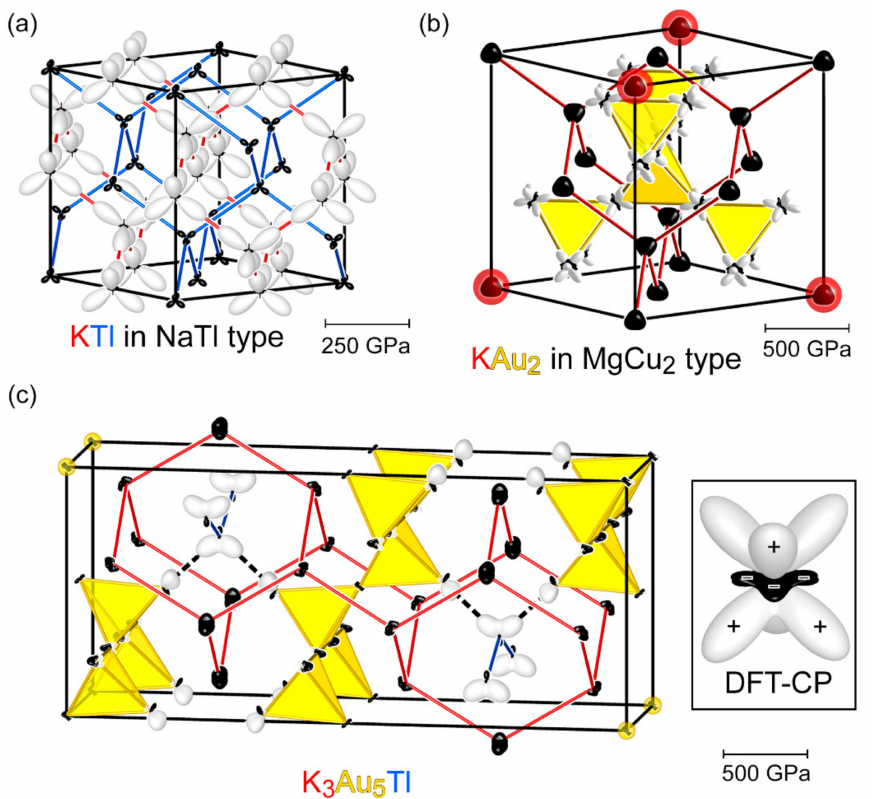
Figure 11. CP driving forces for the formation of K 3 Au 5 Tl from its Laves and Zintl phase parent structures. CP schemes are shown for ( a ) KTl in the NaTl type, ( b ) KAu 2 in the MgCu 2 type, and ( c ) K 3 Au 5 Tl (own type). For all structures, the CP schemes were generated with the assumption of 50% of Bader charges on all atoms (50% ionicity); schemes for other ionicity levels are given in the Supporting